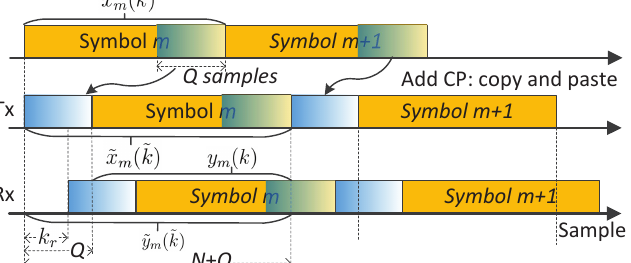
Figure 1. Illustrating the changes in signal timing in OFDM sensing, where CP is short for cyclic prefix and Q is the number of samples in a CP. The top signal, x m ( k ) given in (1), is the essential part of OFDM symbols. The middle signal, ˜ x m ( ˜ k ) given in (3), illustrates the CP-OFDM symbols to be emitted. The bottom signal, ˜ y m ( ˜ k ) given in (4), is the baseband echo at the sensing Rx, where the delay of k r samples account for the round-trip traveling from Tx to